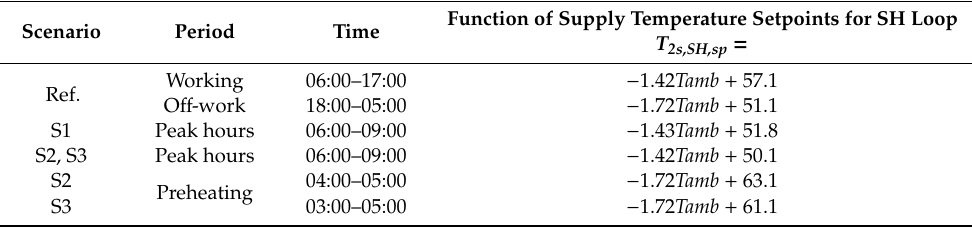
Table 5. Functions of weather compensation curves for all